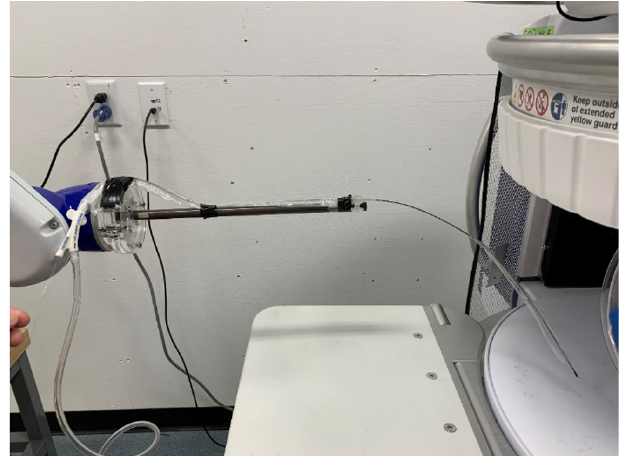
Figure 2. The 7.5 Fr Maquet IABP catheter in the patient opening of the low-field POC MRI system. * IABP: intra-aortic balloon pump, MRI: magnetic resonance imaging, POC: point-of-care.